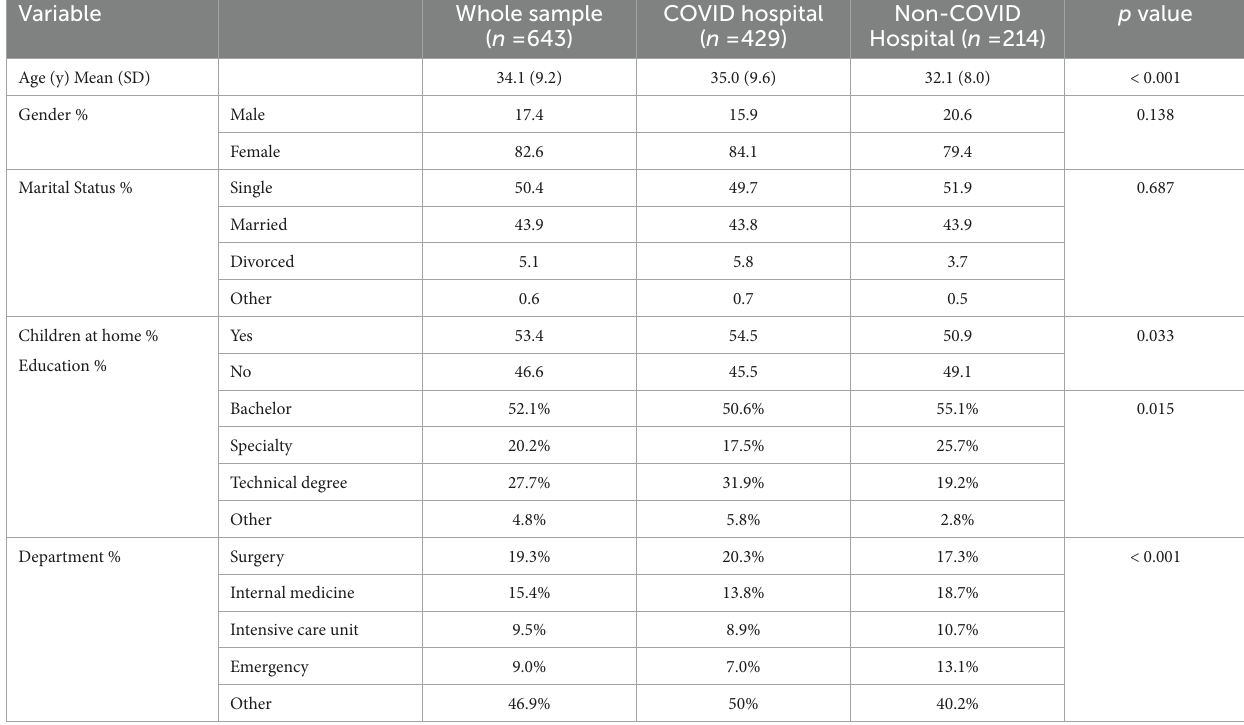
TABLE 1 Baseline characteristics for the whole sample and stratified by